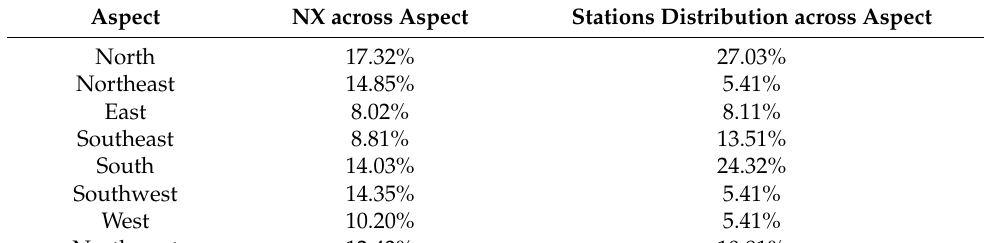
Table 6. Stations distribution and NX across aspect.